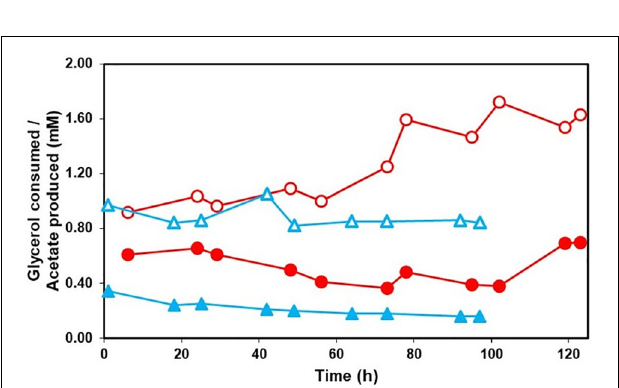
FIGURE 5 | Consumption of glycerol (open symbols) and production of acetate (closed symbols) by the HSB when either synthetic mine water ( (cid:78) , (cid:77) ) or actual MIW ( • , ◦ ) was used as the feed liquor.